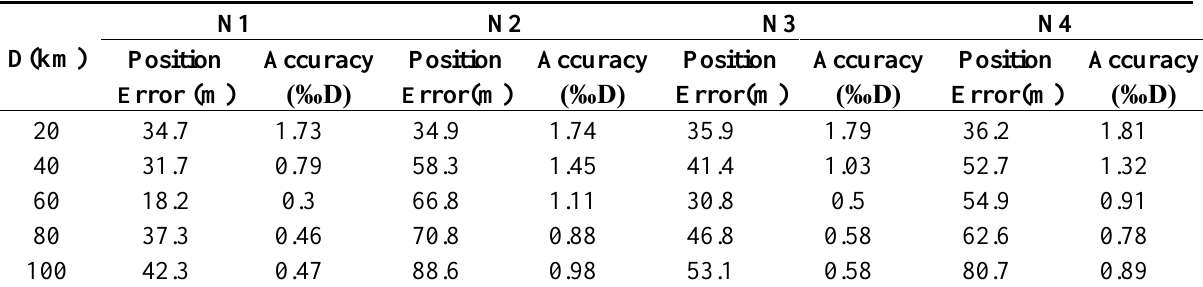
Table 5. On-line experimental results in the river